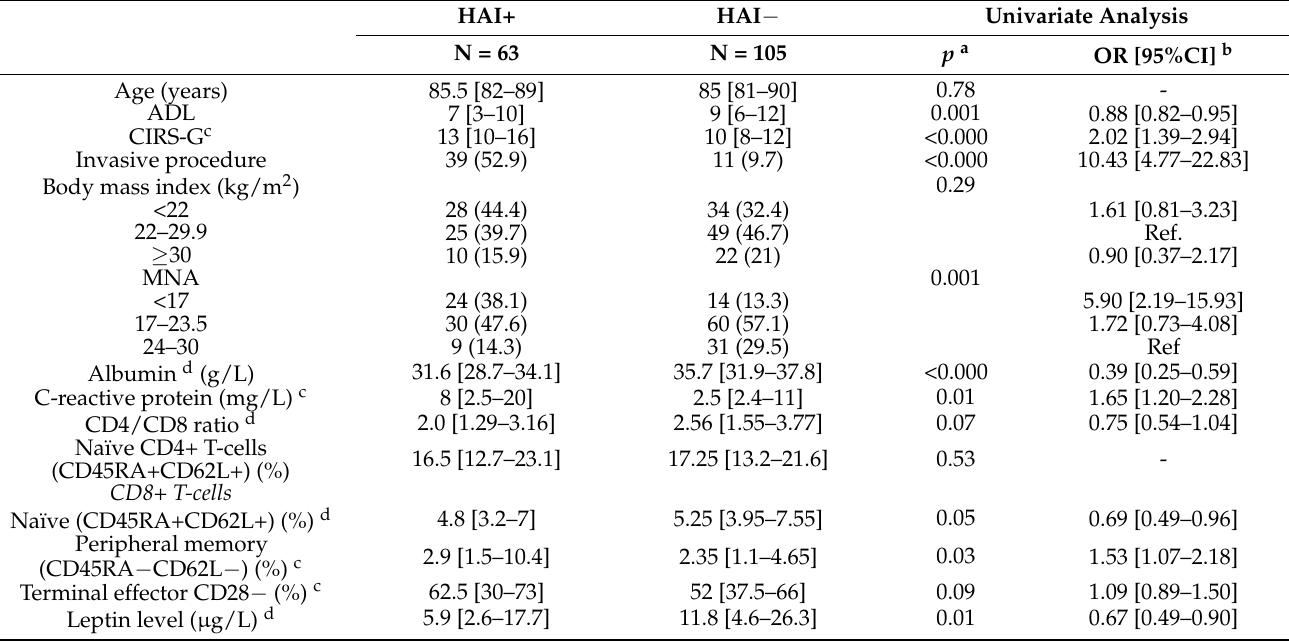
Table 3. Univariate analyses of women with vs. without one of more healthcare-associated infections (n = 168). HAI+ HAI − Univariate Analysis N = 63 N =